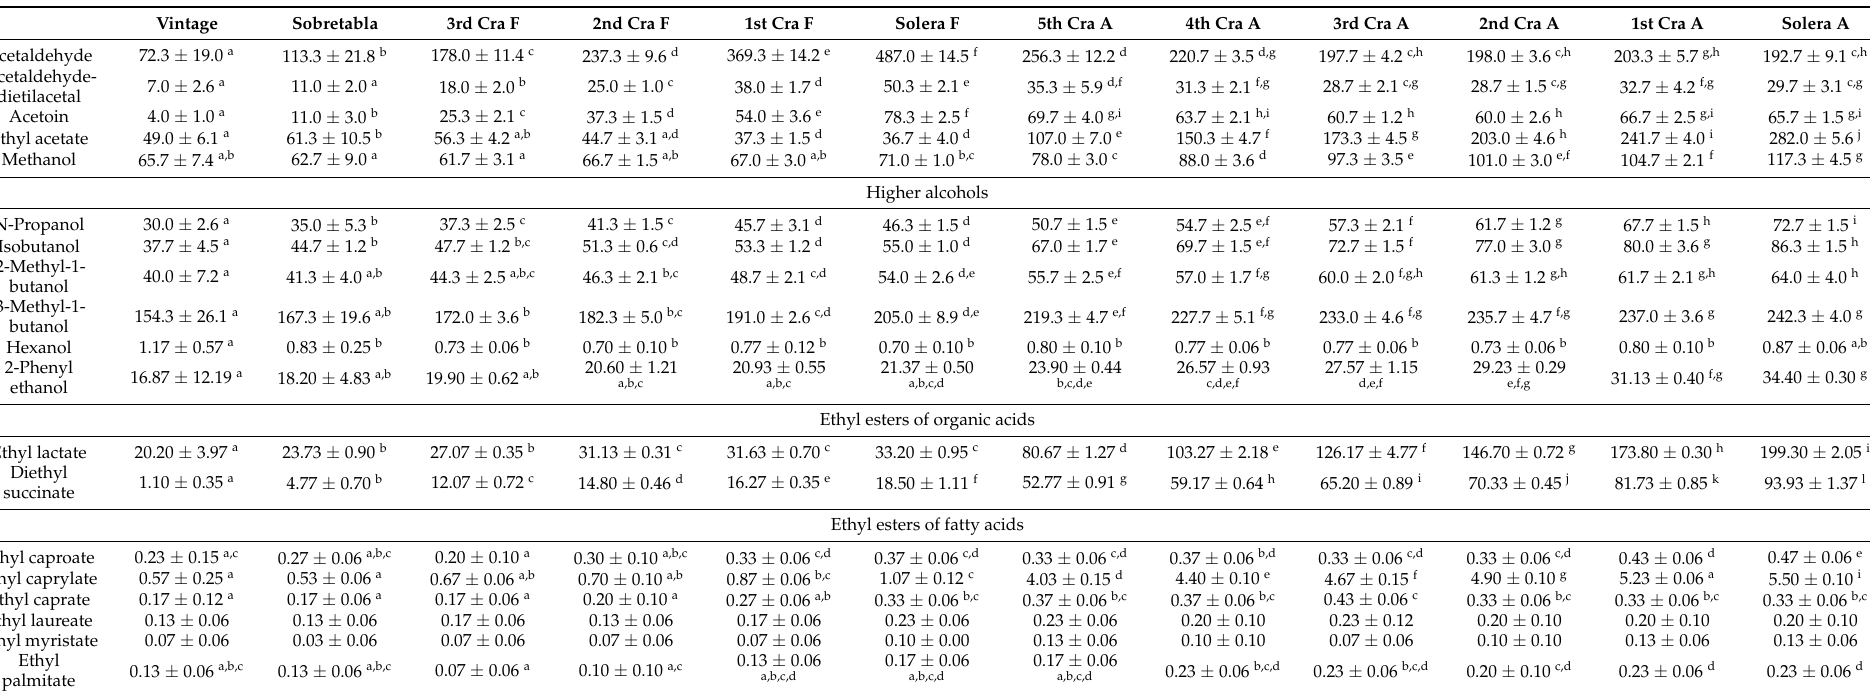
Table 5. Acetaldehyde, acetaldehyde-diethylacetal, acetoin, ethyl acetate, methanol, higher alcohols, ethyl esters of organic acids and ethyl esters of fatty acids in mg/L in the studied Sobretabla, Fino and Amontillado